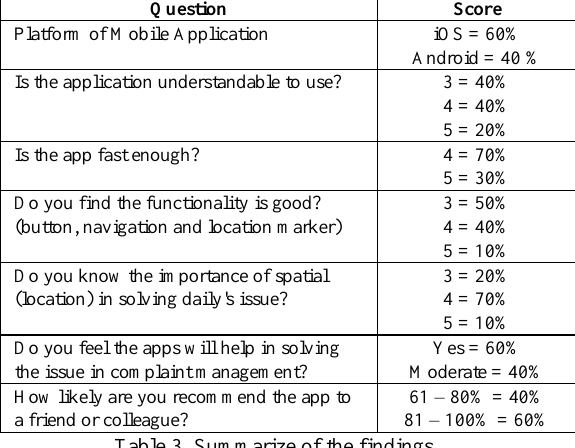
Table 3. Summarize of the